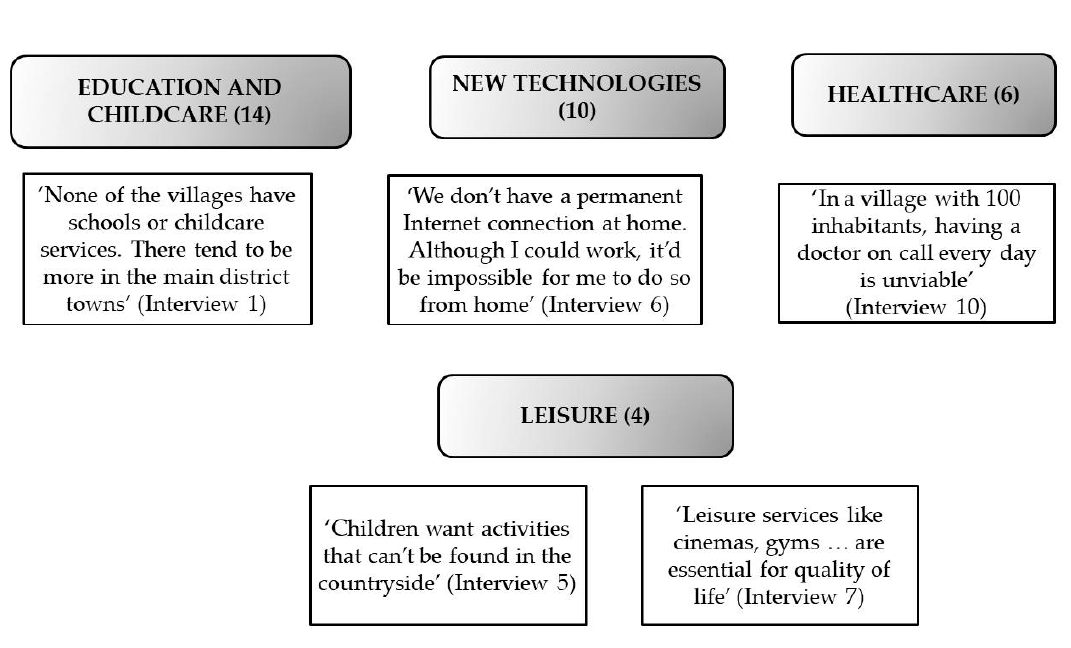
Table 5. Results of the non-parametric Mann Whitney U test for two independent samples.